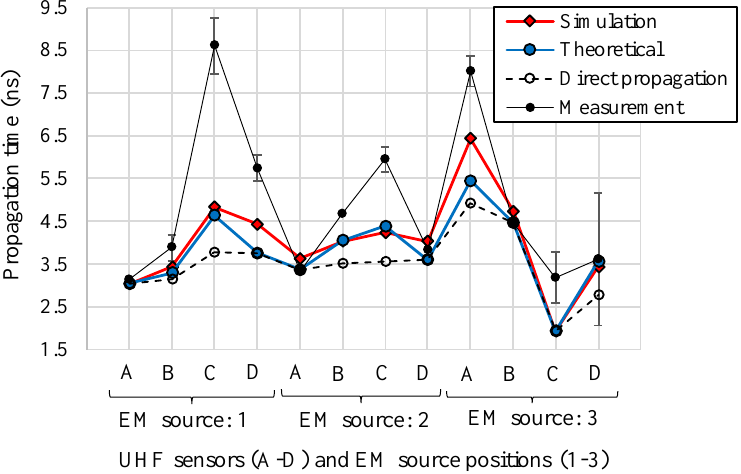
Figure 12. Propagation times of the EM waves by the simulation, experiment and theoretical calculations.